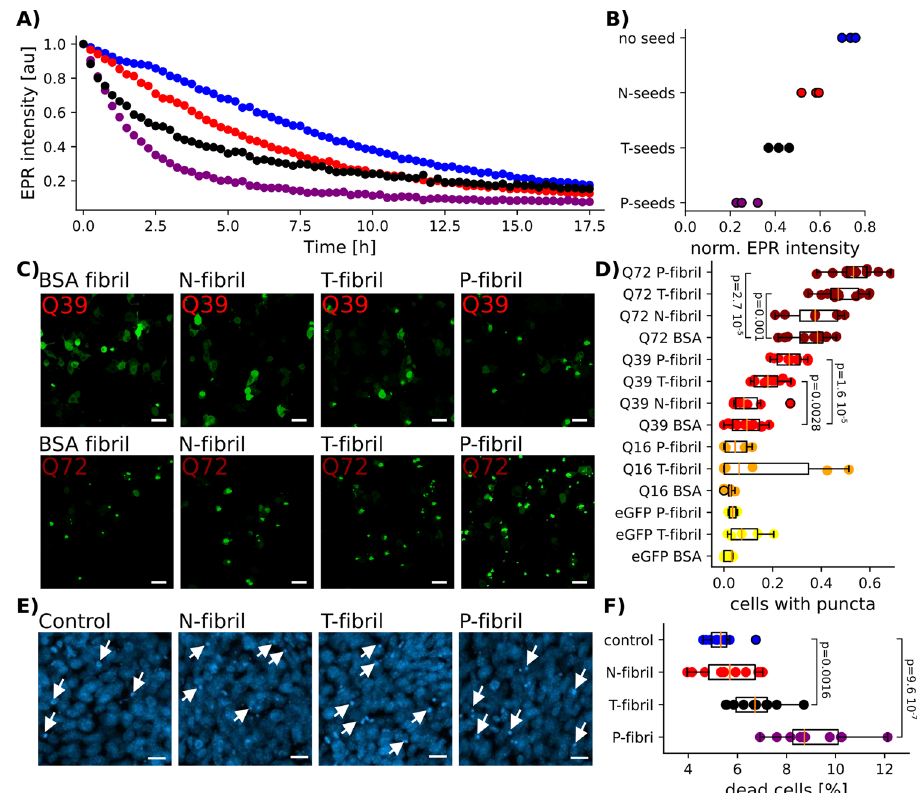
Fig. 7 HTTex1 fi brils with disentangled PRDs are more ef fi cient in seeding soluble HTTex1. a Time-dependent CW EPR intensities of unseeded HTTex1 (Q46) 35R1 (blue) and HTTex1(Q46) 35R1 seeded with N- (red), T- (black), and P- fi brils (purple). b EPR intensity of HTTex1(Q46) 35R1 4 h after initiating fi